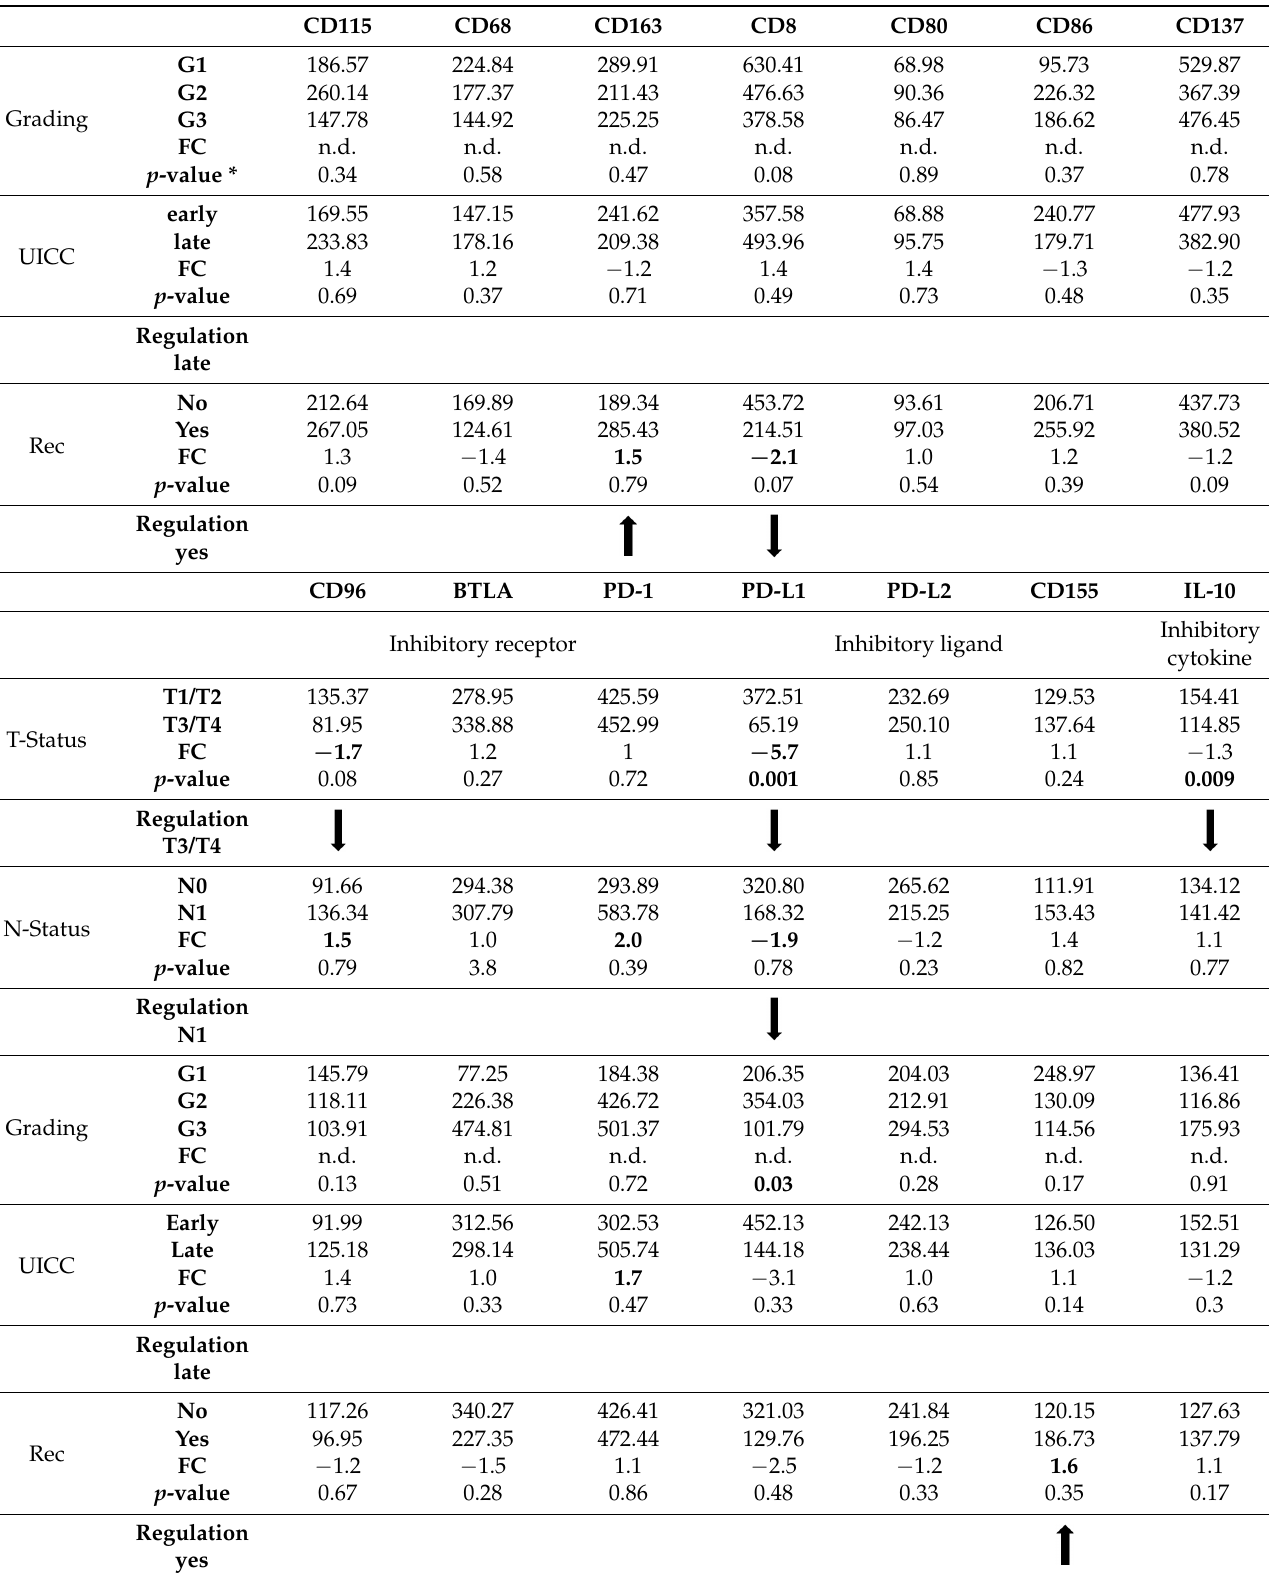
Table 4. Average of counts in specific groups, changes in expression levels (FC) and statistical rele- vance of differential expression in OSCC tissues depending on tumor size, lymph node status (N), clinical stage (UICC), grading (G) and recurrence (Rec.). Number of OSCC = 98. Statistically relevant changes are highlighted in bold. All significances are calculated by means of the MWU test with the exception of grading (* Kruskal–Wallis Test). FC significance level was 1.5 times. Statistically rele- Table 4. Cont . vant changes are highlighted in bold.